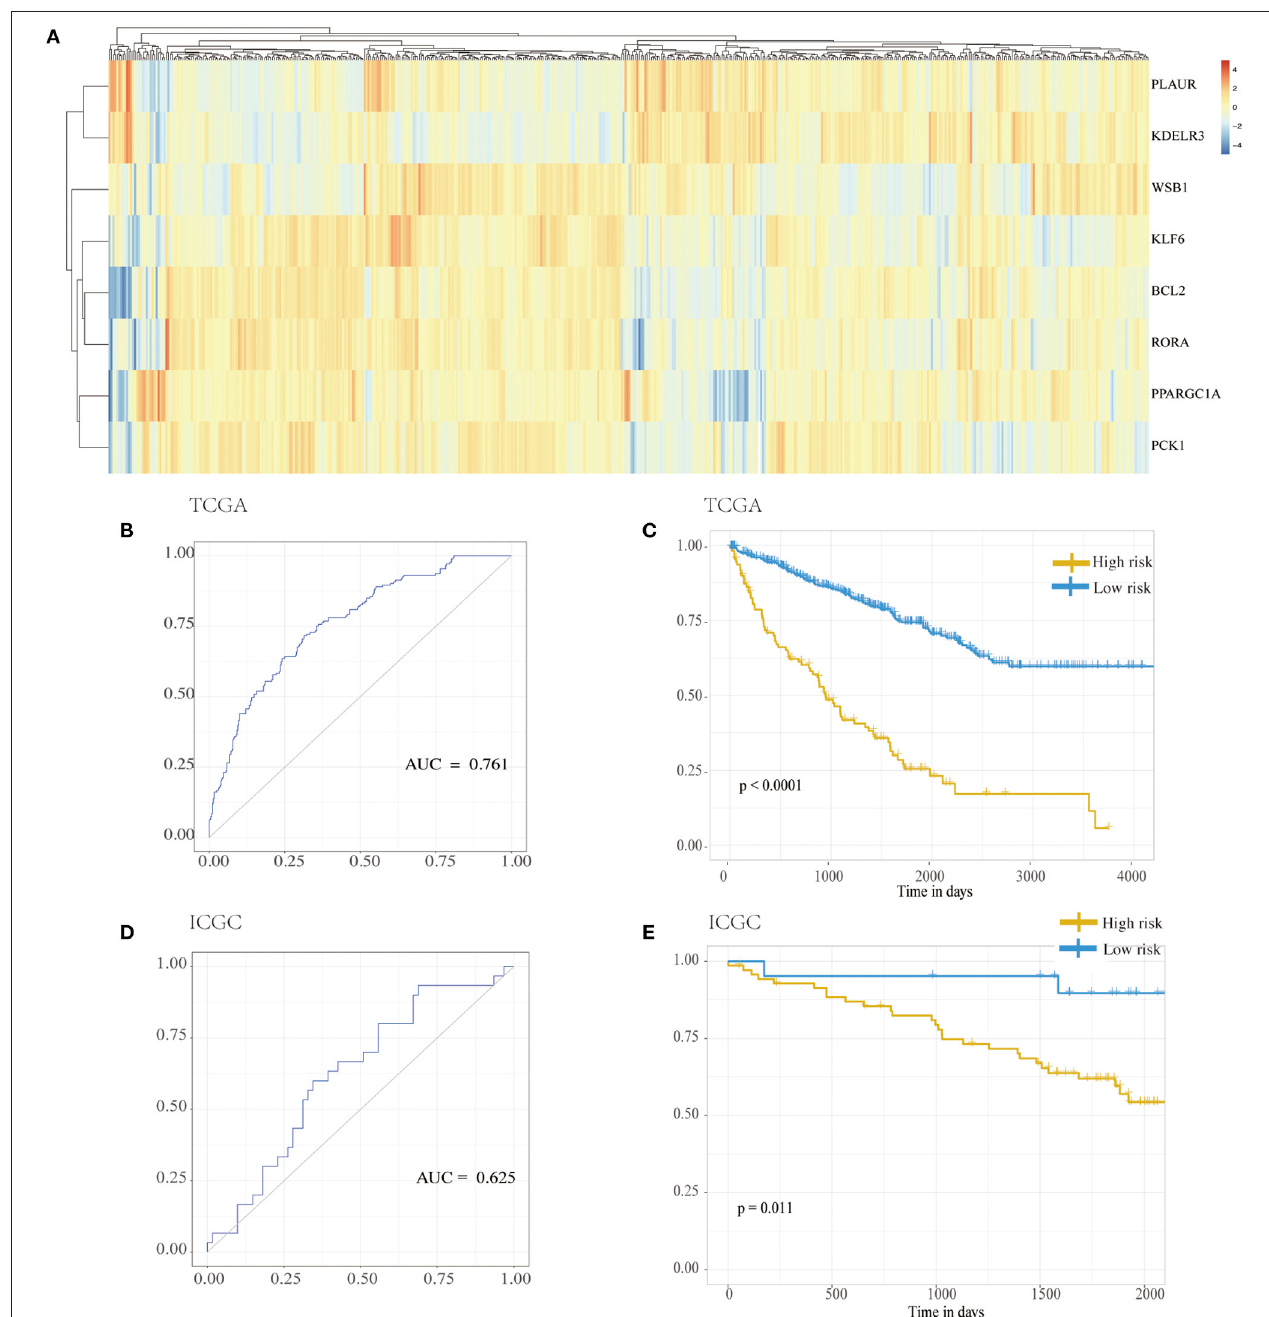
FIGURE 3 | Hypoxia risk model. (A) Distribution of genes in the hypoxia risk model. (B) ROC analysis for the hypoxia risk model. (C) Kaplan–Meier curves for overall survival of risk score in TCGA cohort. (D) ROC analysis for the hypoxia risk model in the ICGC cohort. (E) Kaplan–Meier curves for overall survival of risk score in ICGC cohort. ICGC, International Cancer Genome Consortium; ROC, receiver operating characteristic; TCGA, The Cancer Genome Atlas.